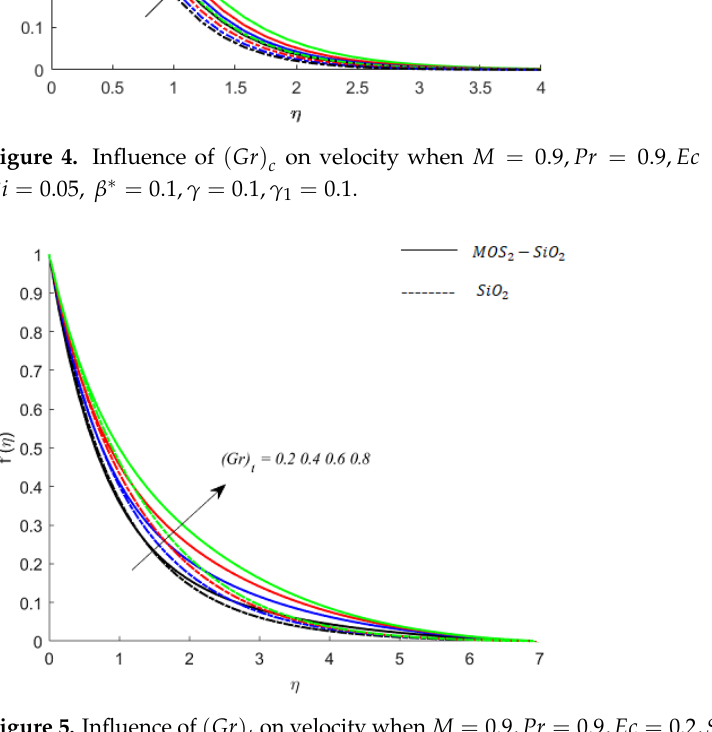
Figure 5. Influence of ( Gr ) on velocity when M = 0.9, Pr = 0.9, Ec = 0.2, Sc = 0.8, K = 0.1,Bi = 0.05, β ∗ = 0.1, γ = 0.1, γ 1 = 0.1 . Temperature of fluid particles and intensity of magnetic field: The 𝑀𝑜𝑆 (cid:2870) − 𝑆𝑖𝑂 (cid:2870) − Casson and 𝑆𝑖𝑂 − Casson fluids are electrically conducting fluids. When electric cur- (cid:2870) rent passes through 𝑀𝑜𝑆 (cid:2870) − 𝑆𝑖𝑂 (cid:2870) − Casson and 𝑆𝑖𝑂 (cid:2870) − Casson fluids, some of the elec- trical energy converts into heat, and this phenomenon is called Ohmic dissipation. This phenomenon is also considered here in this study. The term in dimensionless energy equation involving M is due to Joule heating (Ohmic heating) and determines the impact of Ohmic dissipation on the temperature of the fluid. This dissipated heat raises the kinetic energy of the fluid particles, and therefore, their temperature increases. This effect can be noticed in Figure 6. This figure also demonstrates that the Ohmic dissipation phenomenon in 𝑀𝑜𝑆 (cid:2870) − 𝑆𝑖𝑂 (cid:2870) − Casson fluid is stronger than that in 𝑆𝑖𝑂 (cid:2870) − Casson . Therefore, the rise in temperature of fluid particles of 𝑀𝑜𝑆 (cid:2870) − 𝑆𝑖𝑂 (cid:2870) − Casson is greater than the rise of tem- perature of fluid particles of 𝑆𝑖𝑂 (cid:2870) − Casson fluid . Therefore, the influence of Ohmic dissi- pation on boundary layer thickness associated with the flow of 𝑀𝑜𝑆 (cid:2870) − 𝑆𝑖𝑂 (cid:2870) −